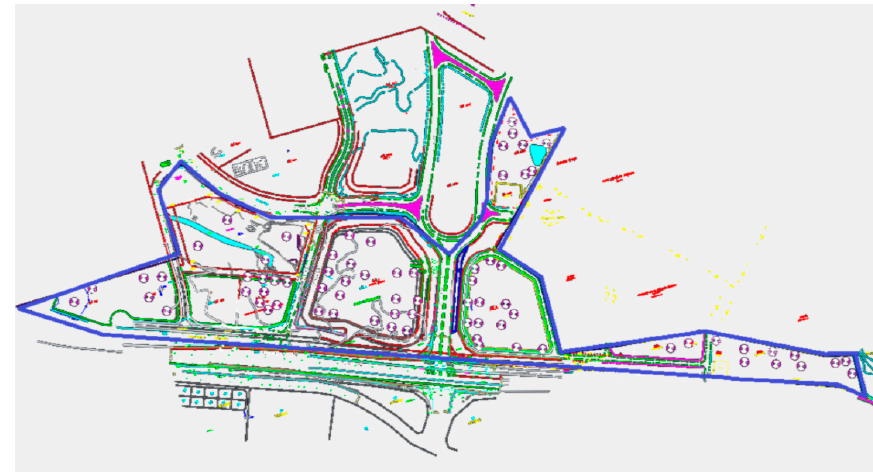
Figure 2. Layout plan of Case Study 1.